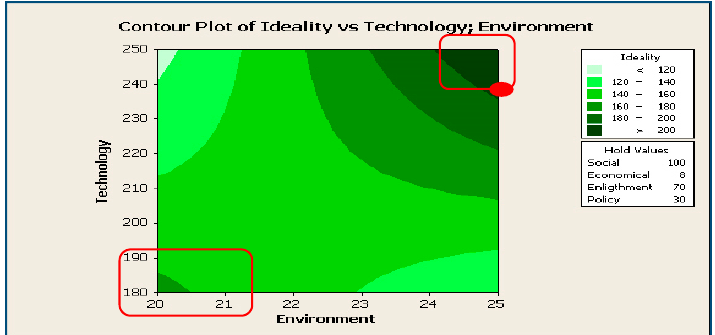
Figure 10. Impact of Environment and enterprises technology interference.